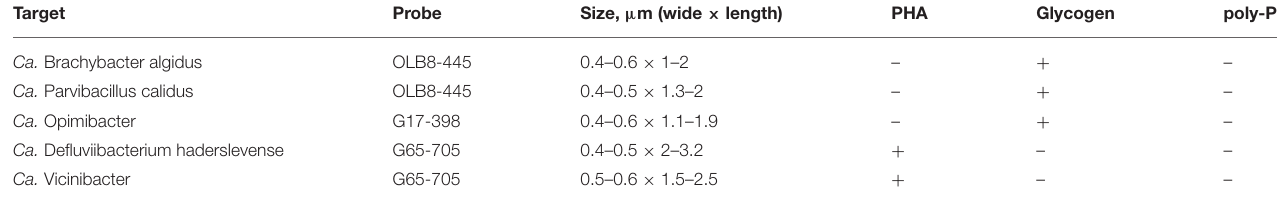
TABLE 1 | Summary table of morphology and presence of intracellular storage polymers detected by FISH and FISH–Raman microspectroscopy in the Saprospiraceae species of